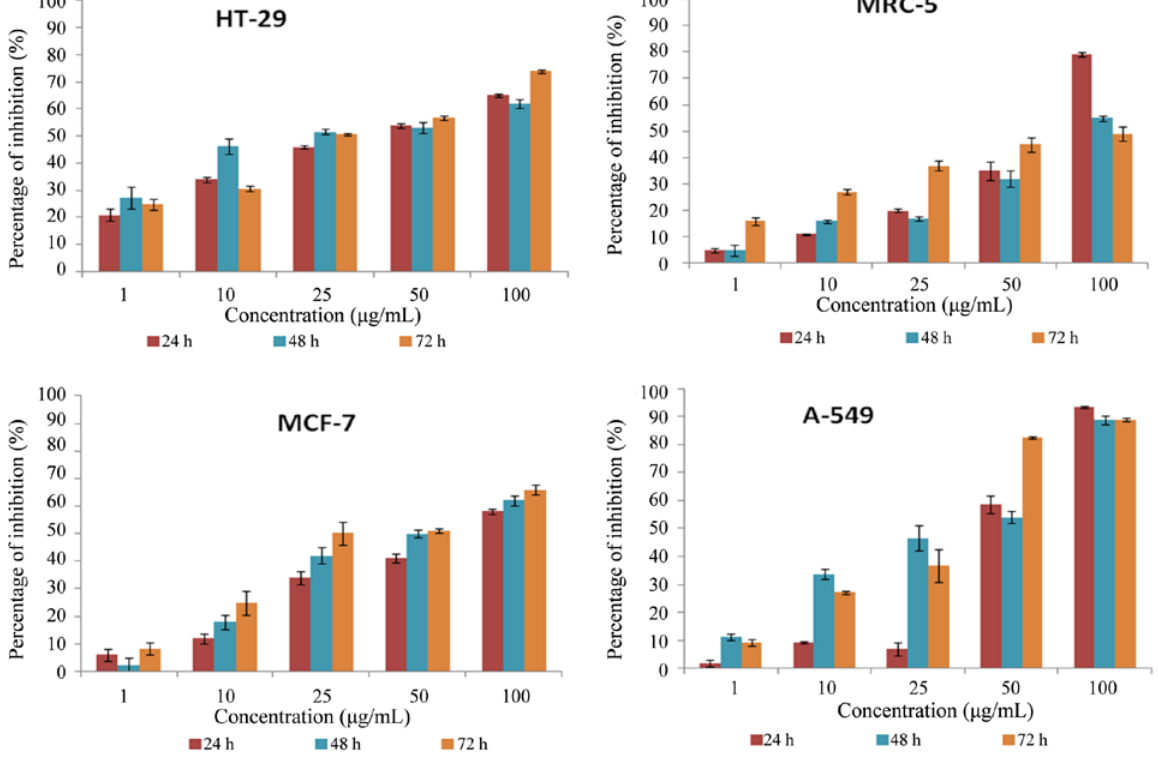
Figure 3. In vitro , cytotoxic effects of DMHE on HT-29 colon cancer cells, CaSki cervical cancer cells, MCF-7 breast cancer cells and MRC-5 normal lung cells. Cells were treated with various concentrations of DMHE from the ethyl acetate fraction of Phaleria macrocarpa (Scheff.) Boerl fruits for 24, 48 and 72 h prior to the determination of cytotoxicity by MTT cell proliferation assay. Each value is expressed as mean ± standard deviation of three